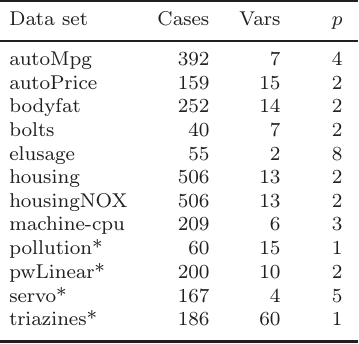
Table 1. The basic properties of the data sets (number of data cases and input variables) and the maximum order of the polynomials for SFS and RMHC. * denotes data sets the order of cases was left unchanged as it was already ran- domized, for all other data sets the order was randomized. Data